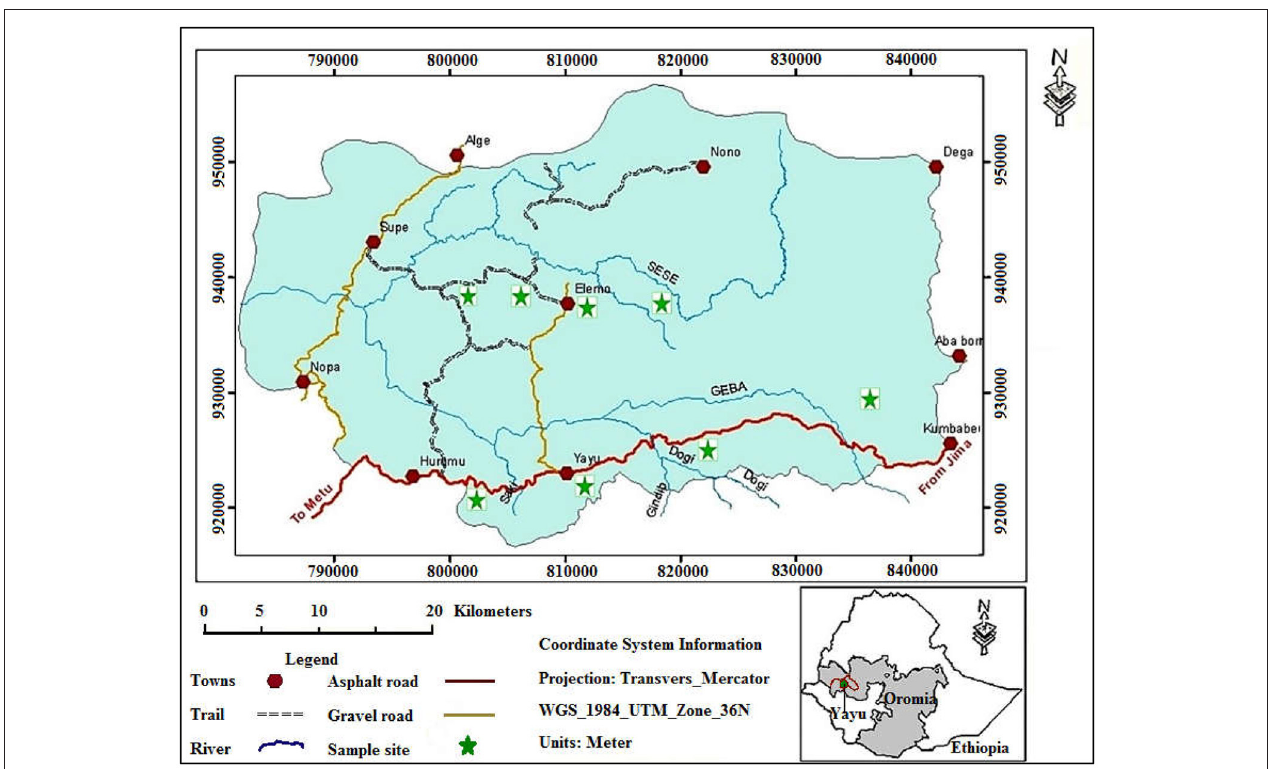
FIGURE 1 | Map of Yayu in Ethiopia (adapted from Ilfata, 2008).